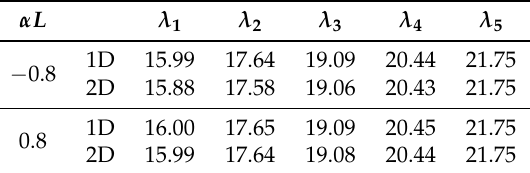
Table A2. Eigenvalues for the longer spirals.